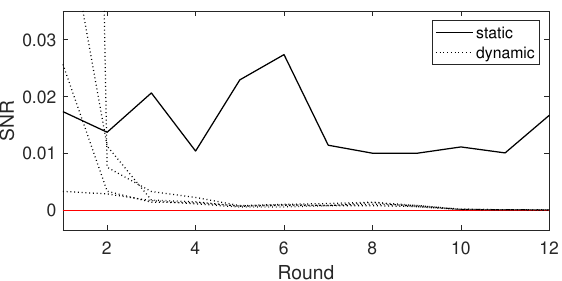
Figure 11: Maximum (nibble wise) signal-to-noise ratio (SNR) computed for all 12 round inputs for the static power measurements.